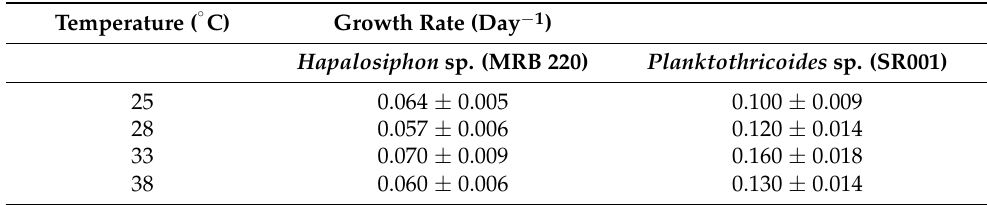
Table 2. Growth rates under different temperature